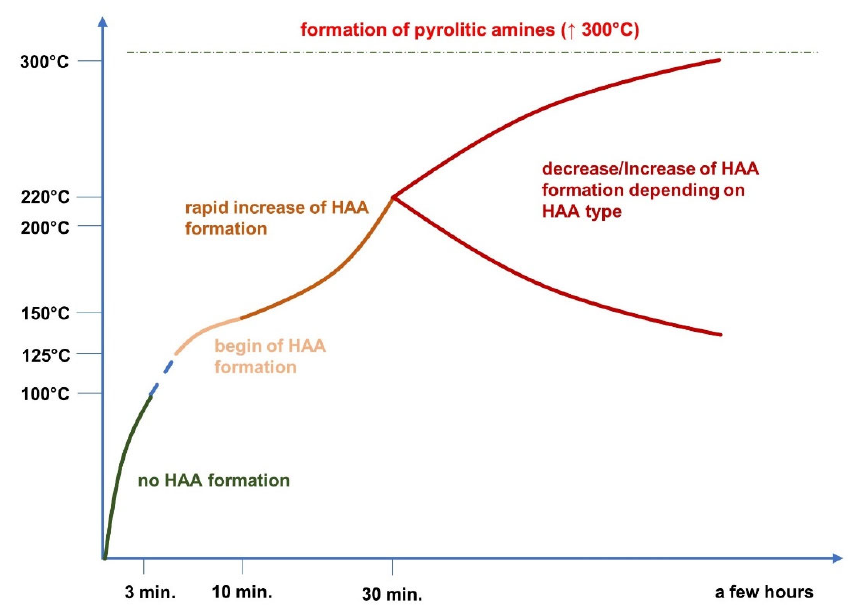
Figure 1. Changes in the content of HAAs depending on applied temperature and time.